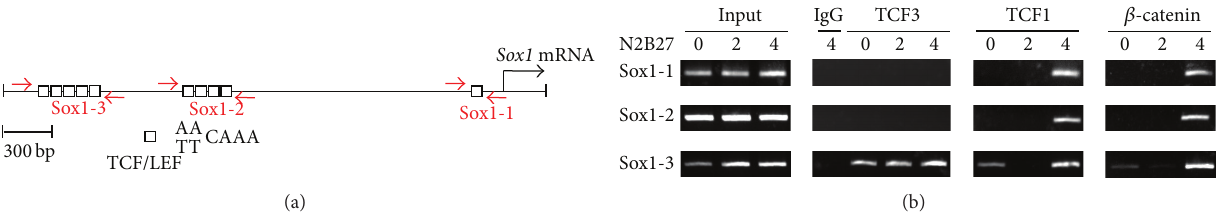
Figure 6: Increased Wnt/ 𝛽 -catenin signaling directly regulates Sox1 promoter activity during neural differentiation. (a) Schematic representation of binding sites for TCF/LEF transcription factors in a 3 kb promoter region of the Sox1 gene. Three pairs of PCR primers were designed based on potential TCF/LEF binding sites. (b) ChIP analysis of the mouse Sox1 promoter with 𝛽 -catenin, TCF1, or TCF3 antibodies. 𝛽 -catenin and TCF1 bound to the Sox1 promoter from day 4 during neural